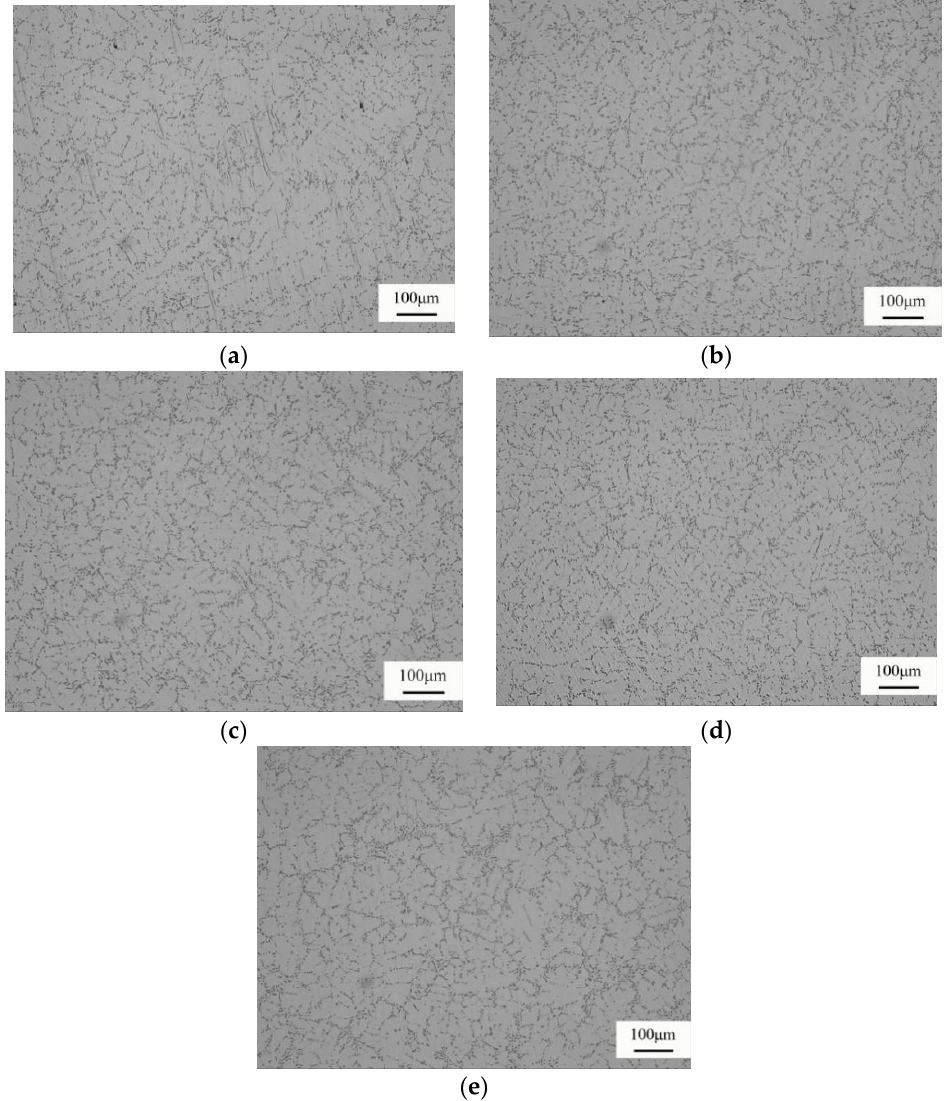
Figure 3. T6 metallographic diagram of A357 alloy with different Ce content. ( a ) 0%, ( b ) 0.08%, ( c ) 0.16%, ( d ) 0.24%, and ( e ) 0.32%.